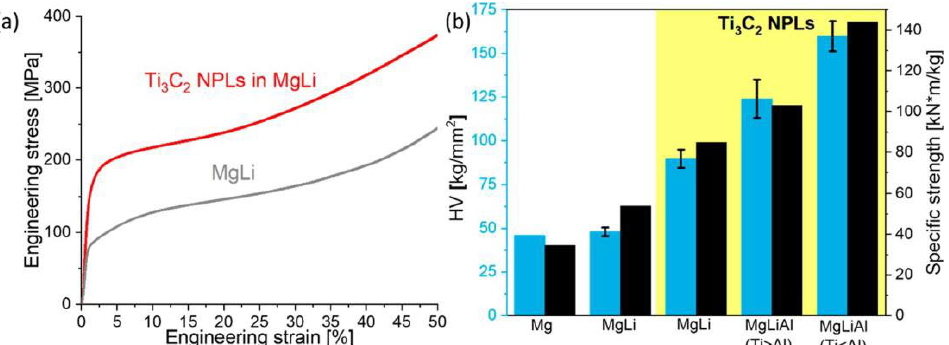
Figure 32. ( a ) Compressive engineering stress–strain curves for the Mg-Li alloy MMCs containing Ti 3 C 2 NPLs (red) and Mg-Li alloy without any particles (gray). ( b ) Summary of the specific yield strength and Vickers hardness for the composites of Ti 3 C 2 NPLs in Mg-Li and Mg-Li-Al alloys. Reprinted with permission from [73]. Copyright 2019 American Chemical Society.